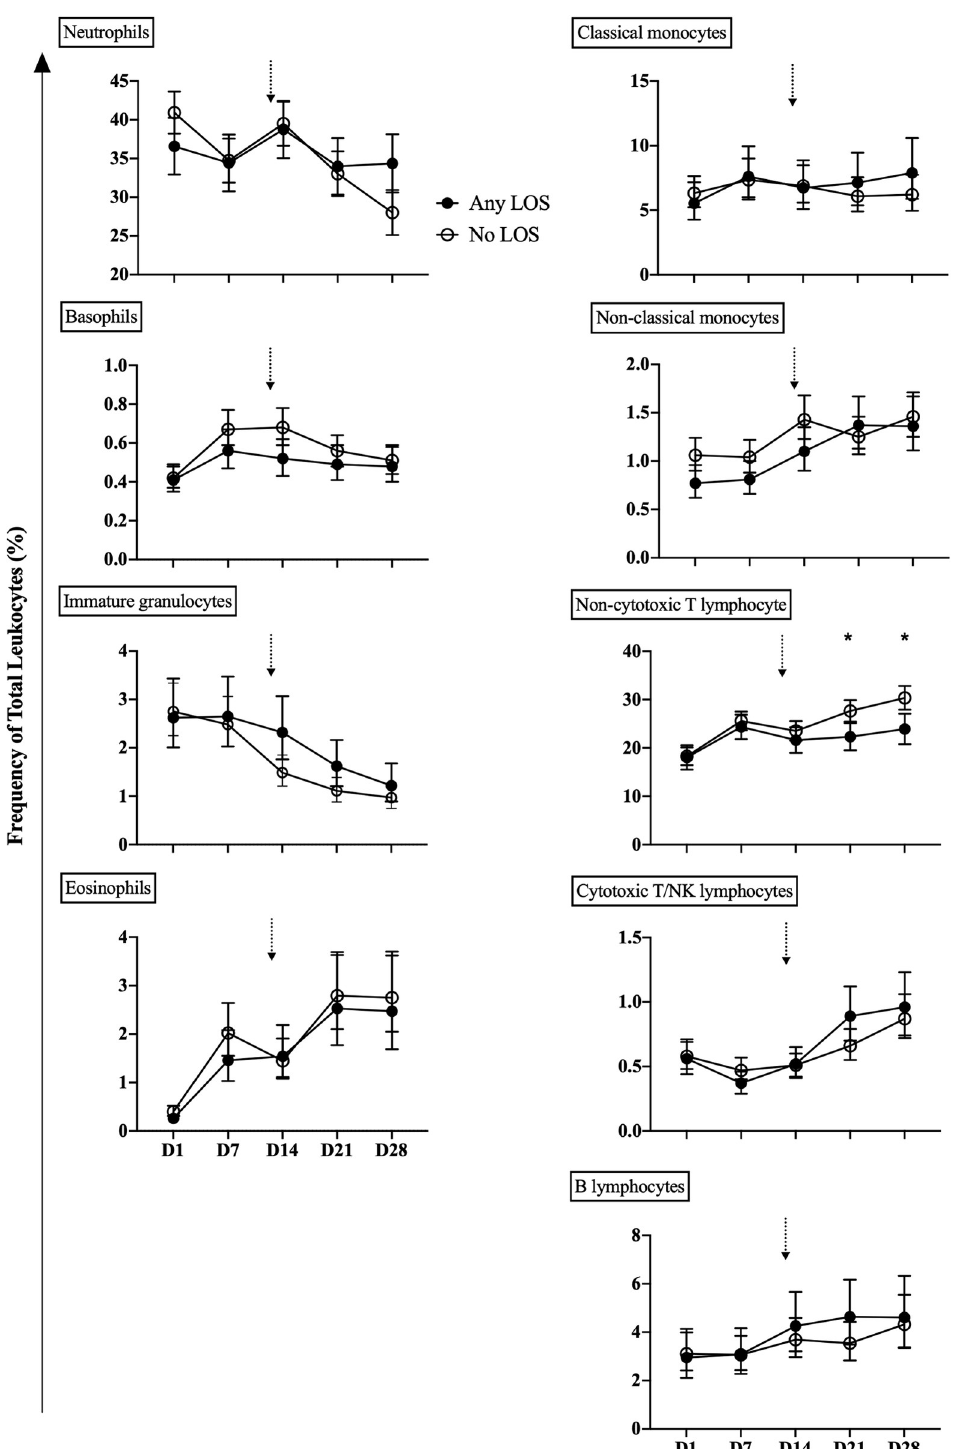
Fig 2. Leukocyte frequency. The percentage of total CD45 + granulocyte, monocyte and lymphocyte populations from preterm infants with any LOS (confirmed and clinical; closed circle) and no LOS (open circle). Analysis was performed by mixed linear regression analysis using a random effects model that was adjusted for known confounders, GA, birth weight z-score, sex and total leukocyte count. Data shown as geometric mean with 95% confidence intervals. Arrows indicated the median age of LOS onset of 13 days in infants in the any LOS group. � Comparison between preterm infants with any LOS and no LOS at the specified time point; level of significance indicated by symbols, e.g. � P < 0.05. https://doi.org/10.1371/journal.pone.0264768.g002 PLOS ONE | https://doi.org/10.1371/journal.pone.0264768 March 2,